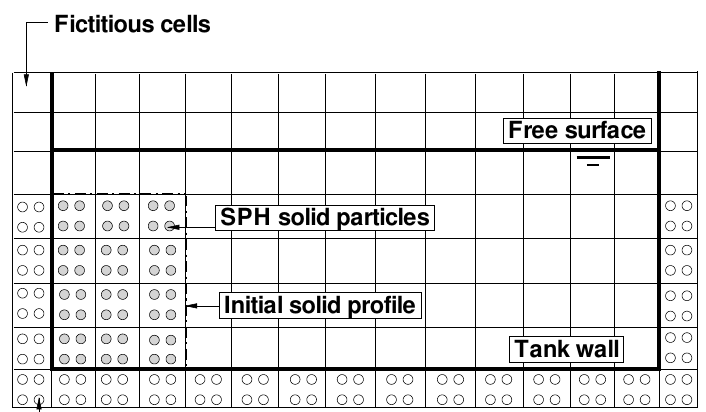
Figure 1. Domain